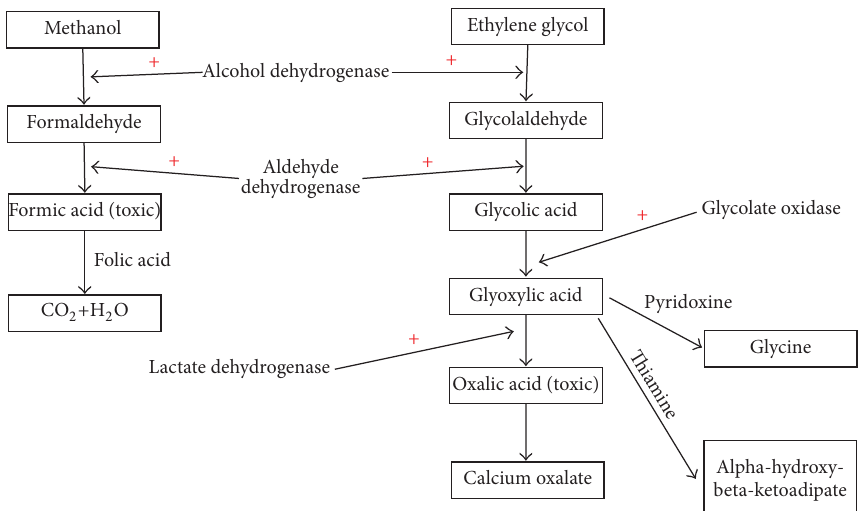
Figure 1: An overview of in vivo methanol and ethylene glycol metabolism.